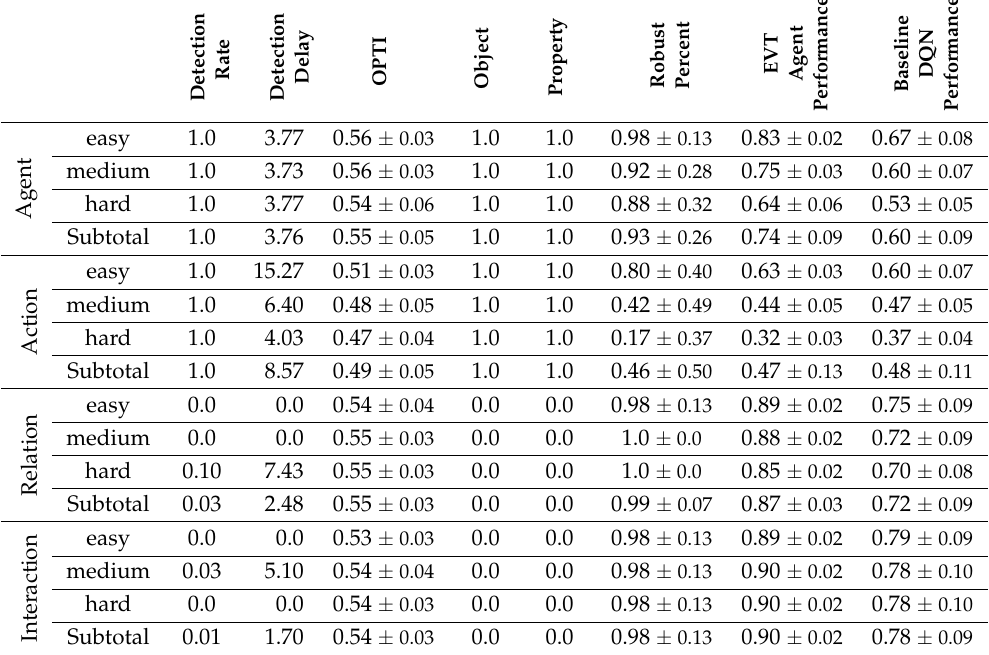
Table 1. Performance of EVT-based detection with 1&2 step lookahead WOW-agent. FP rate was 0 for all EVT-based tests. The detection performance was perfect for agents and actions and near zero for relations and interaction—the latter were, however, nuisance novelties as robustness was near 100%. The performance of the DQN WOW-agent on the same trials is shown at the far right of table. The difference is statistically